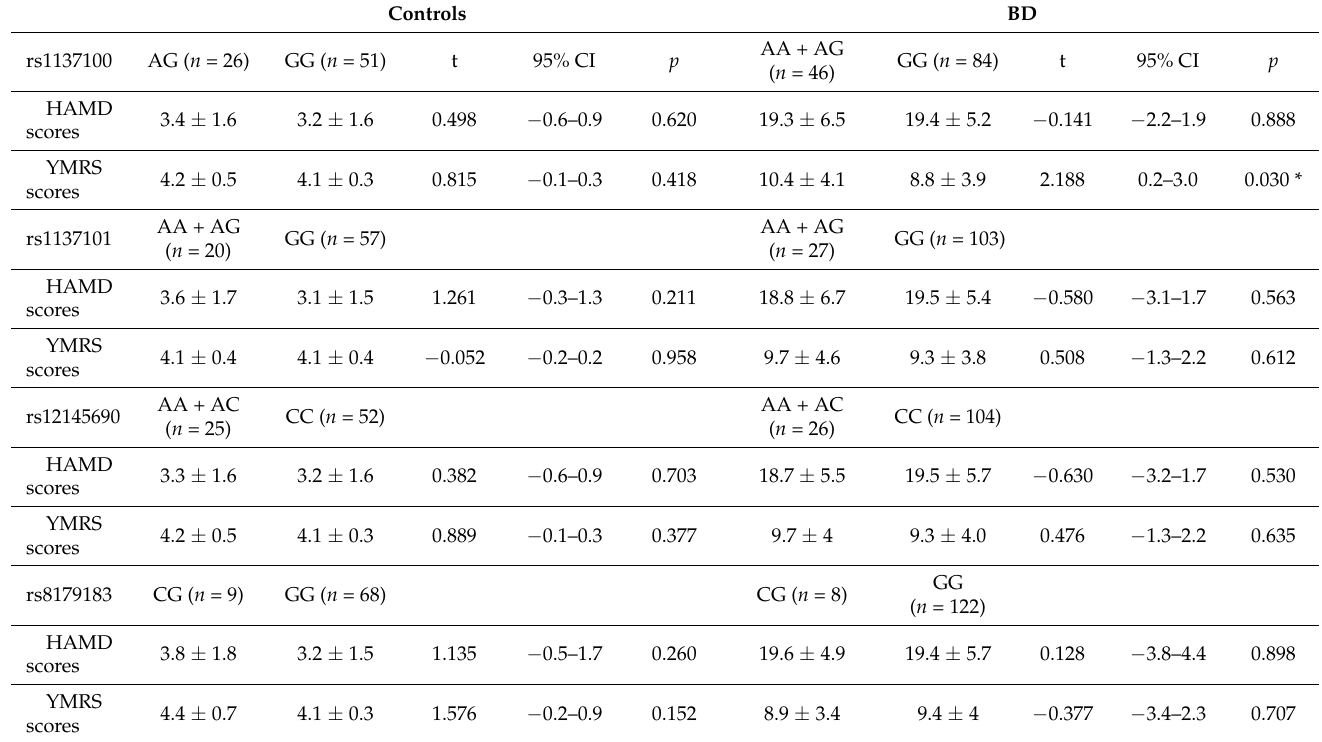
Table 2. The YMRS and HDRS scores in controls and BD patients subgrouped by LEPR polymorphisms. Controls